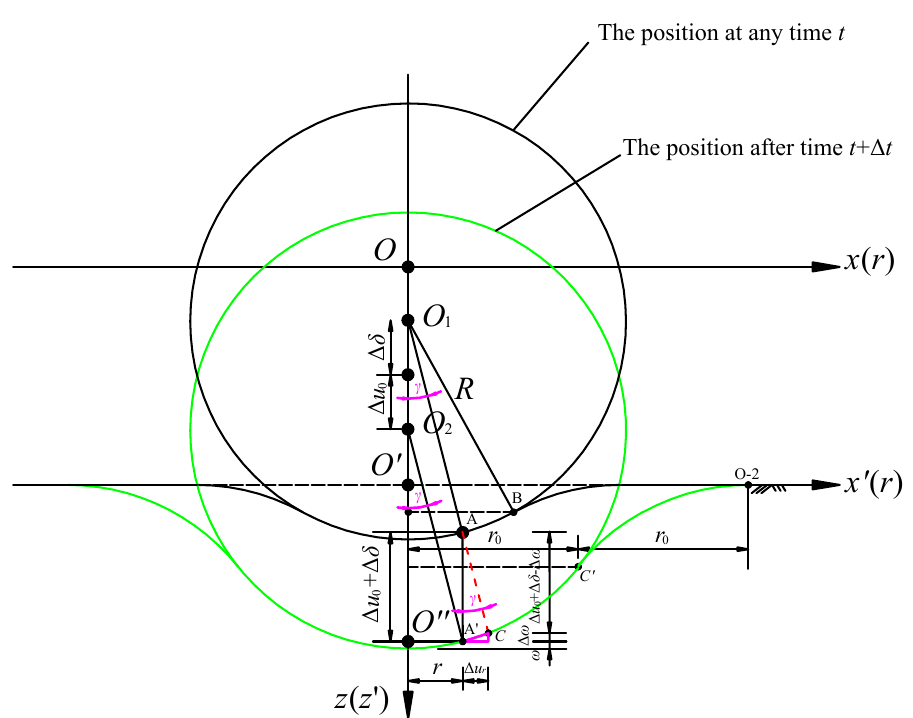
Figure 4. Schematic diagram of the direction and existence of vertical and lateral displacement increments in the contact area.